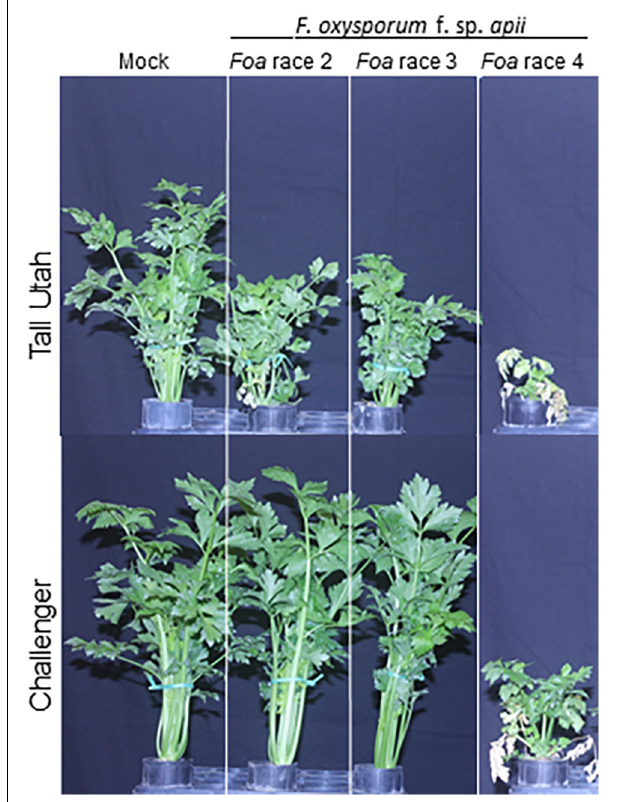
FIGURE 1 | Virulence of three F. oxysporum f. sp. apii ( Foa ) races on celery cultivars Tall Utah and Challenger. Two-month-old celery cultivars were transplanted into uninfested soil (mock) or soil infested with a Foa race. After 49 days, the median plant ( n = 20) in height was photographed. Tall Utah 5270R-Improved is susceptible to the three races and Challenger is resistant to Foa races 2 and 3 but susceptible to Foa race 4. The image is a portion of a figure from Henry et al. (2020). BMC Genomics 21, No. 730 and is reprinted in accordance with BMC Genomics.